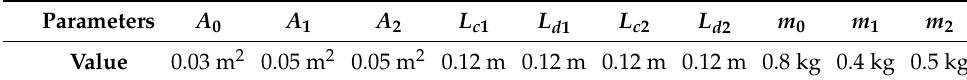
Table 1. The specific values of the parameters in Figure 1. Parameters